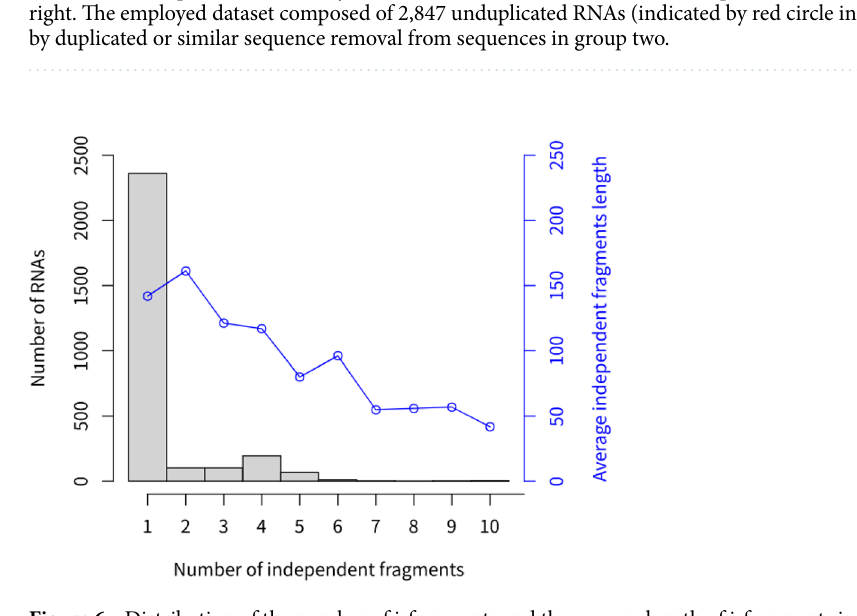
Figure 6. Distribution of the number of i-fragments and the average length of i-fragments in RNAs. The black bars correspond to the black y-axis on the left, while the blue dots correspond to the blue y-axis on the right. The employed dataset composed of 2,847 unduplicated RNAs (indicated by red circle in Fig. 2) obtained by duplicated or similar sequence removal from sequences in group